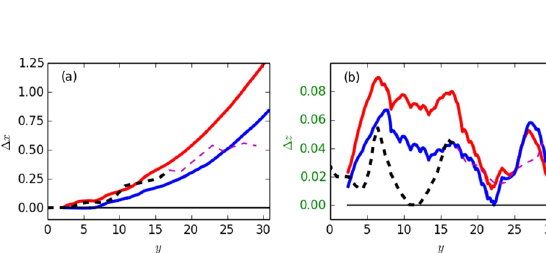
Figure 6. Corrected trajectory plots for filtered (red) and unfiltered (blue) data (in m). (a) The horizontal displacement Δ x, and (b) the vertical displacement Δ z, from the straight trajectory are shown. The straight trajectory assumption, i.e.